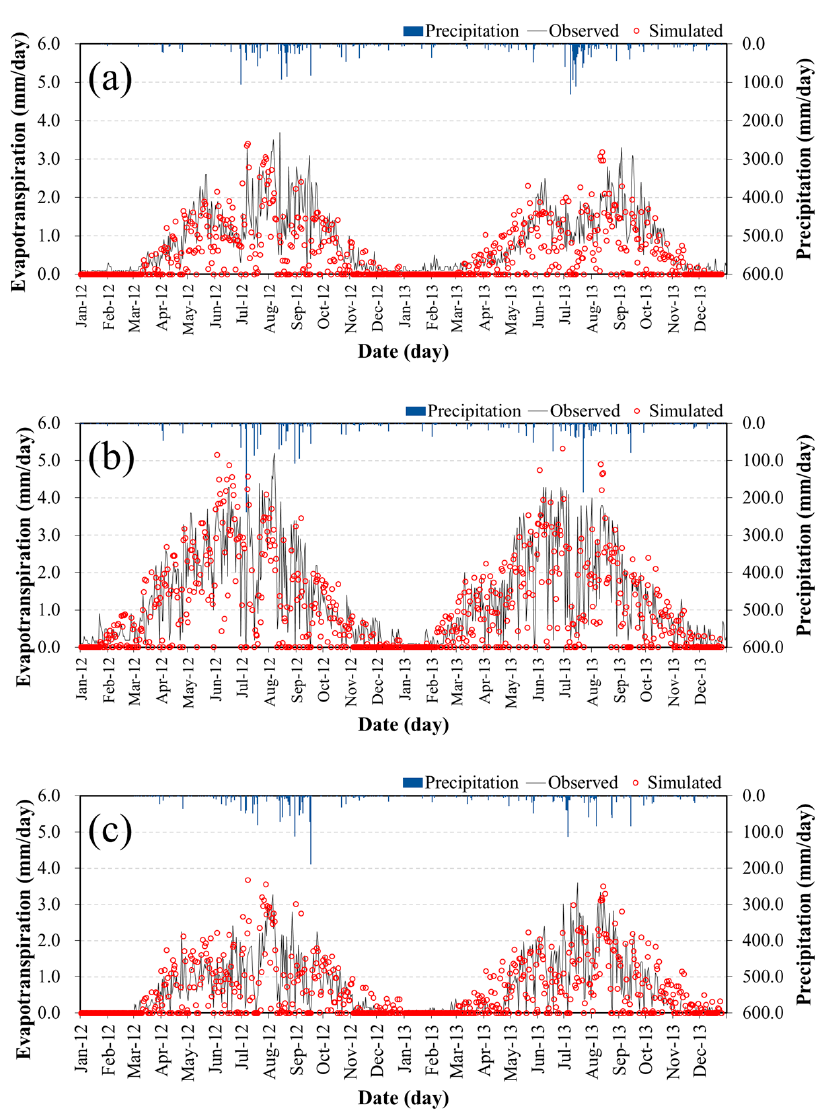
Figure 7. Time series of SEBAL (simulated) and flux tower (observed) ET for: ( a ) SMK; ( b ) CFK; and ( c ) DMK. Table 3. Statistical summary of the SEBAL ET and flux tower ET for two years (2012 to